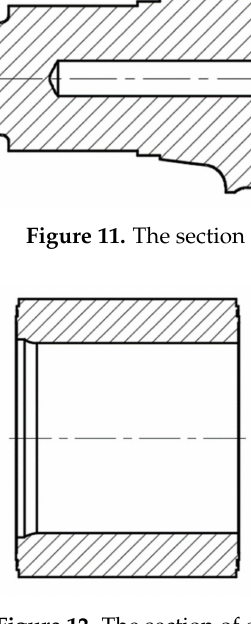
Figure 12. The section of optimization model of roller sleeve.